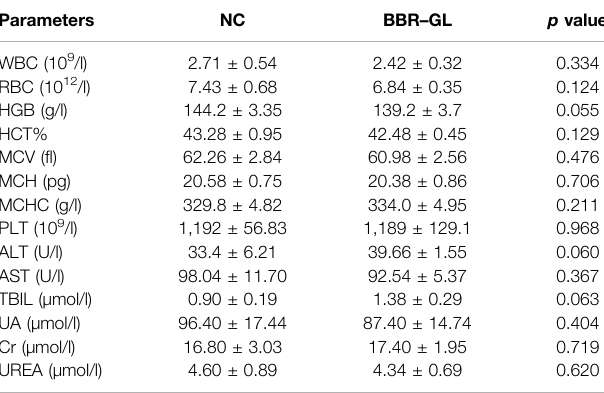
TABLE 4 | Hemolytic parameters in CBC analysis of the blood and biochemical analyses of liver and kidney function indexes of the serum from NC- or BBR – GL-treated